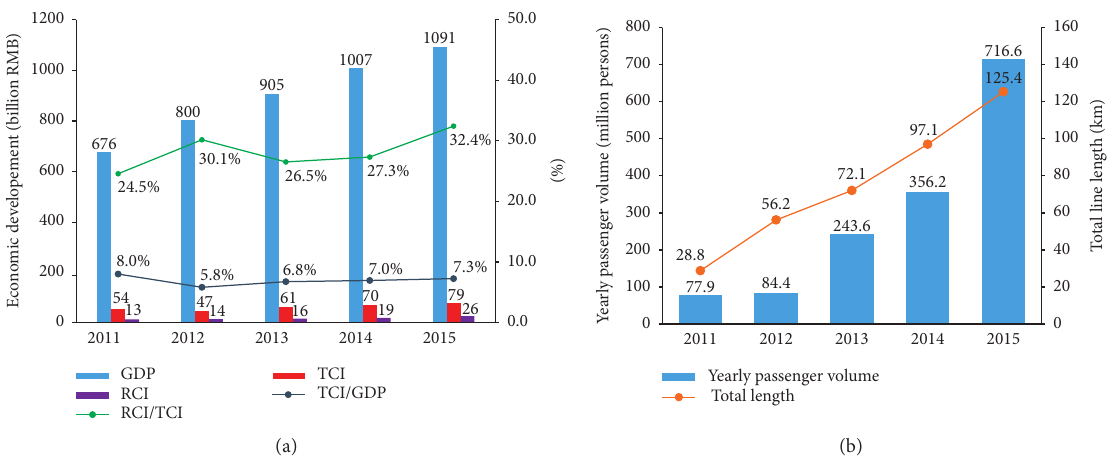
Figure 1: Rail transit construction investment (a) and total mileage (b) in Wuhan. GDP, TCI, and RCI mean the gross domestic product, traffic construction investment, and rail transit construction investment in the increasing service frequency, is a possible solution to